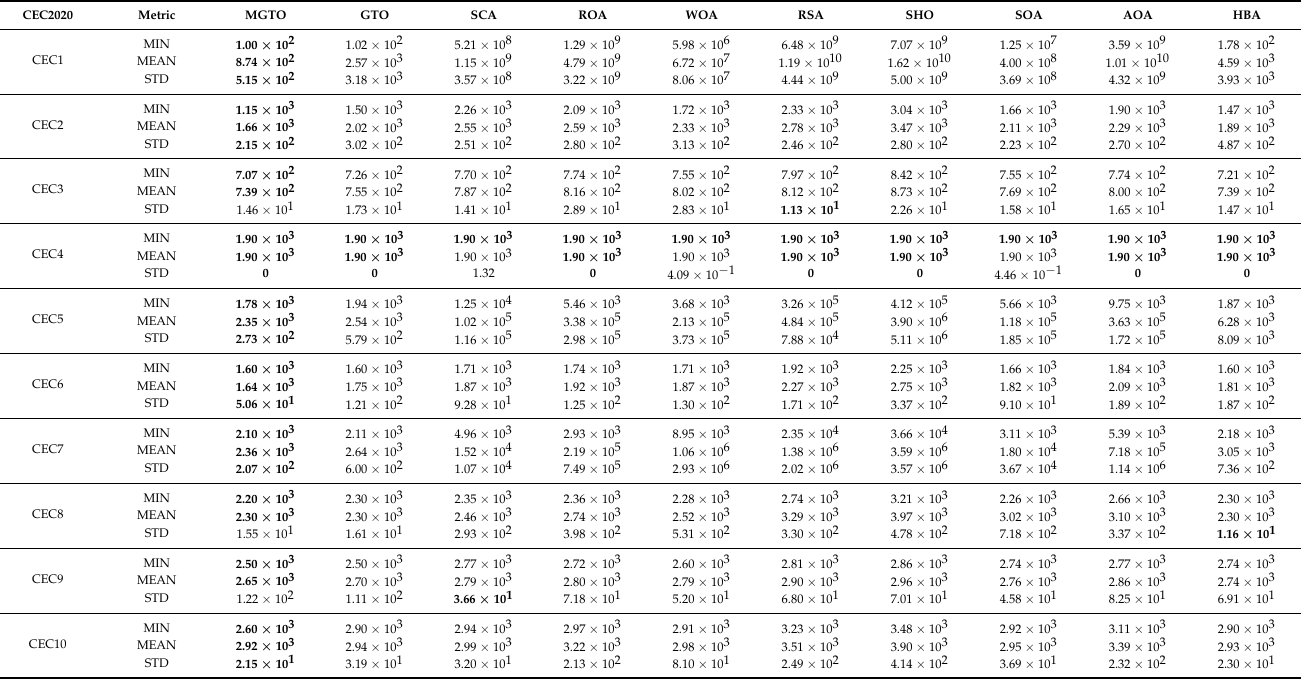
Table 6. CEC2020 Algorithm Results of Benchmark